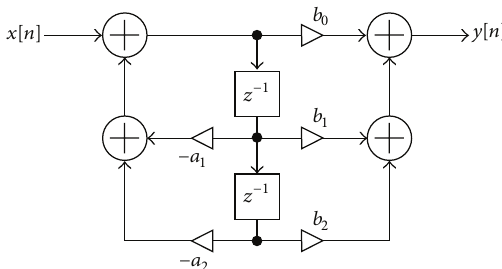
Figure 2: Direct-form 2 implementation of a biquadratic (or se- cond-order) filter